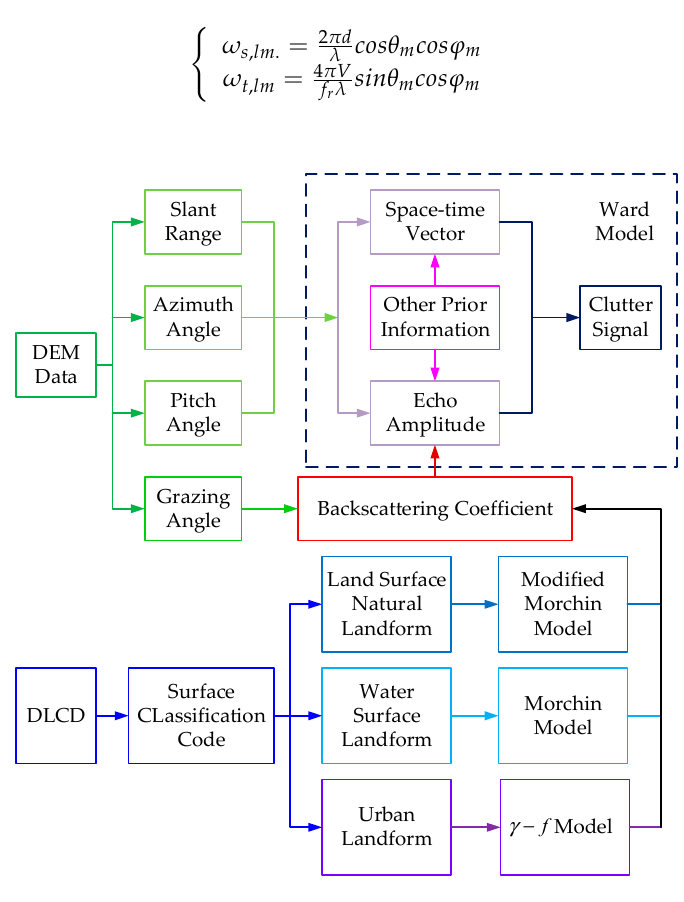
Figure 2. Flow chart of geographic information processing based on DEM and DLCD.